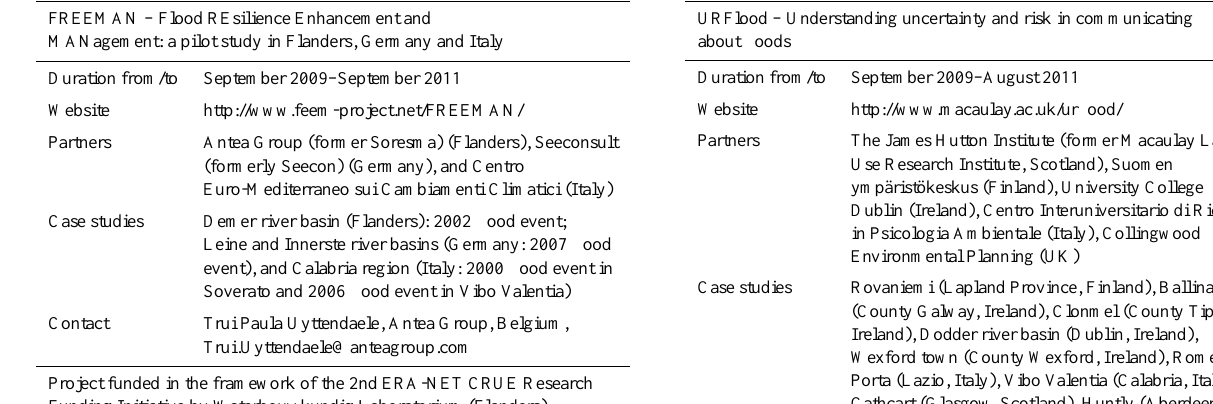
Table A3. Details of the FREEMAN project. Table A4. Details of the URFlood project.